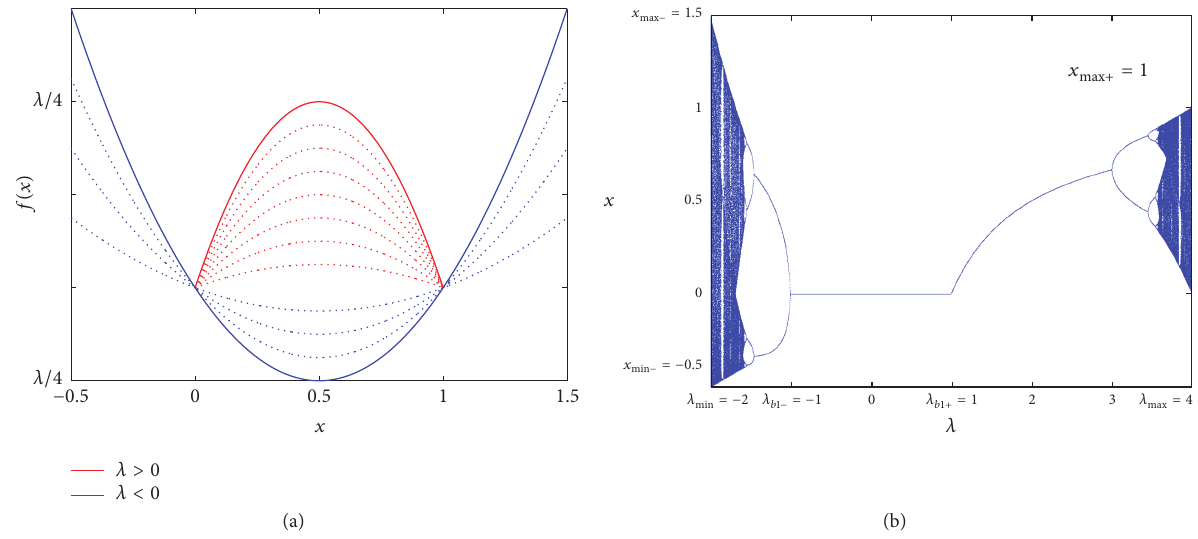
Figure 1: (a) Graph of 𝑓(𝑥) = 𝜆𝑥(1 − 𝑥) . (b) Bifurcation diagram of 𝑓(𝑥) versus the control parameter 𝜆